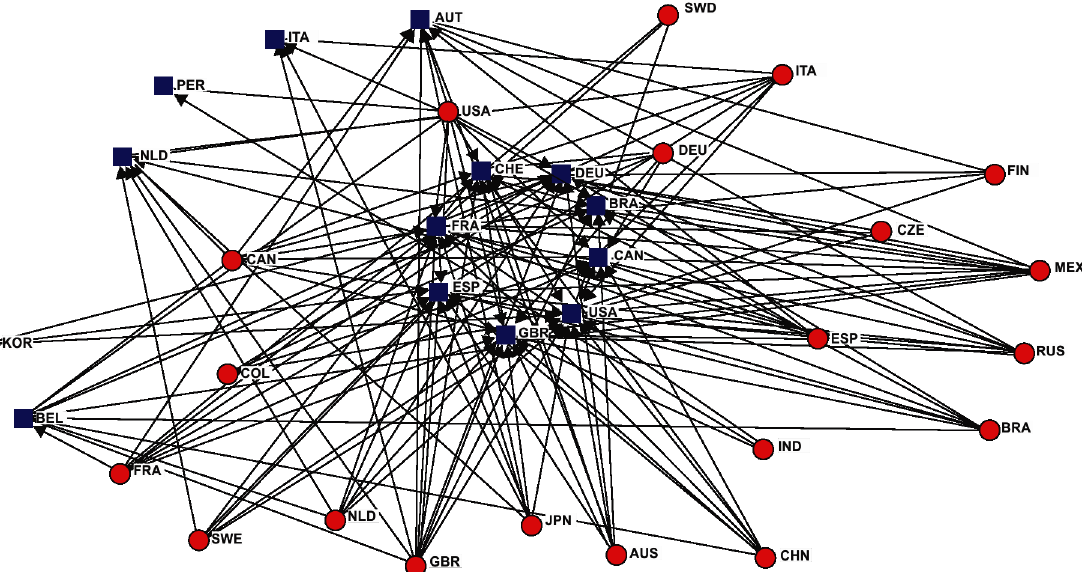
Fig 1. Collaboration Network, using Netdraw from UCINET. We adjust the scaling/ordination from which we select the nearest Euclidian method. Note: We have positioned at the center of the "Fig. 1" the seven countries with the most relationships. Red circles correspond to countries of residence and blue squares to countries of scientific